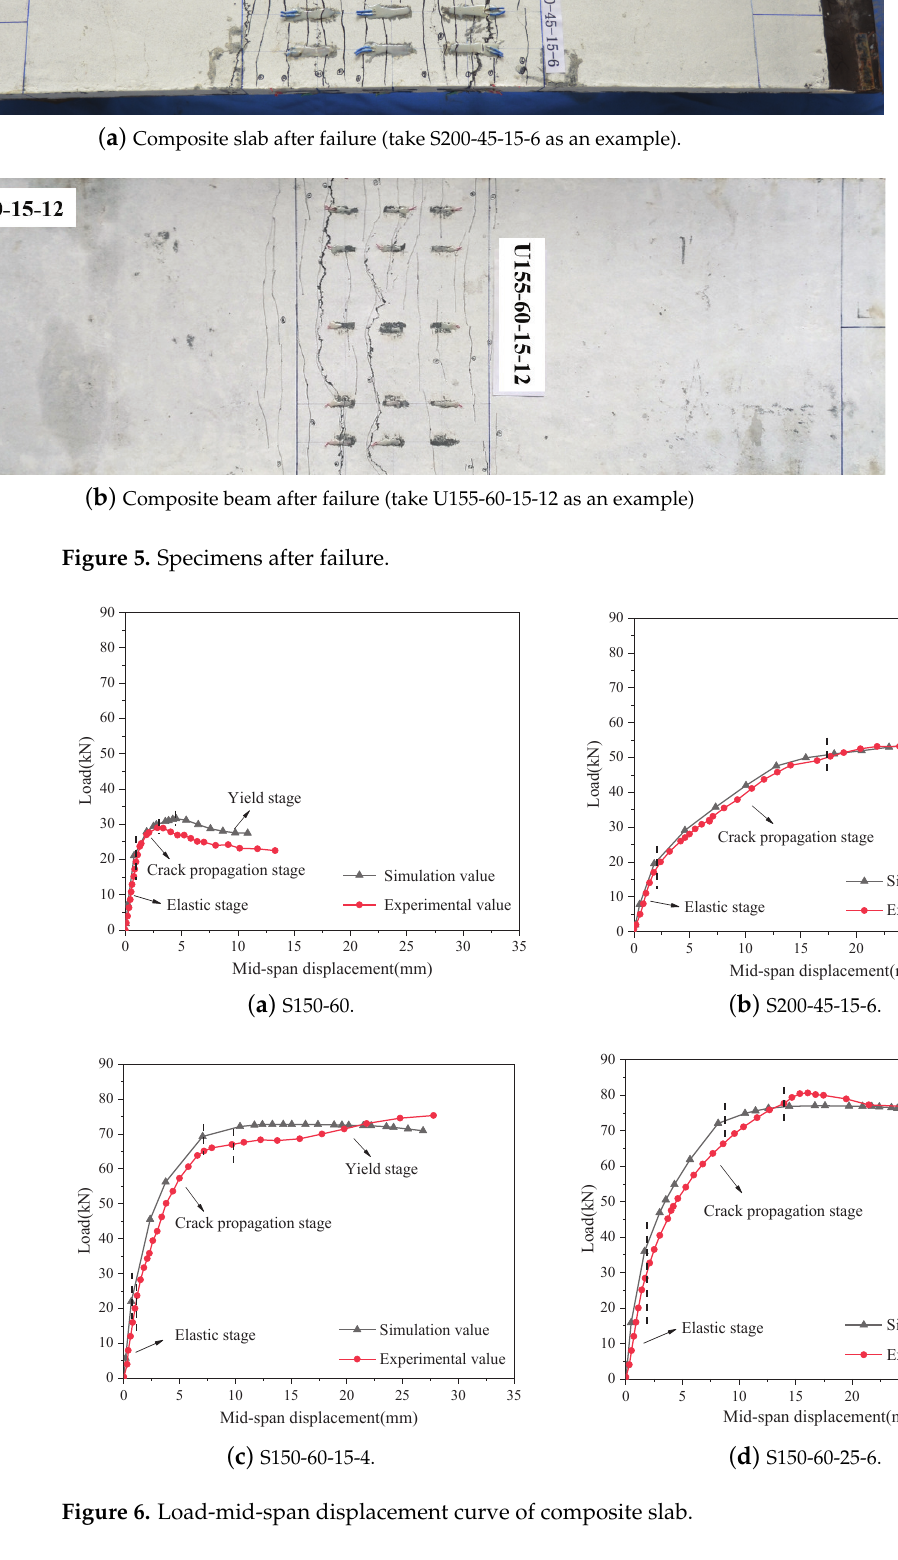
Figure 6. Load-mid-span displacement curve of composite